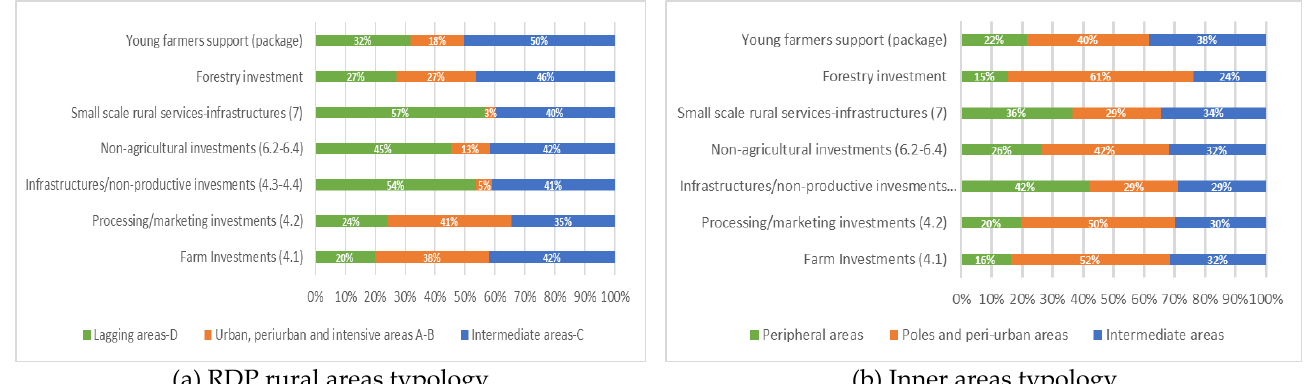
Figure 9. Percentage of total committed expenditures by RDP rural areas and type of investment (RDP and IAS). Source: authors’ elaborations from the data base of funded investment projects.